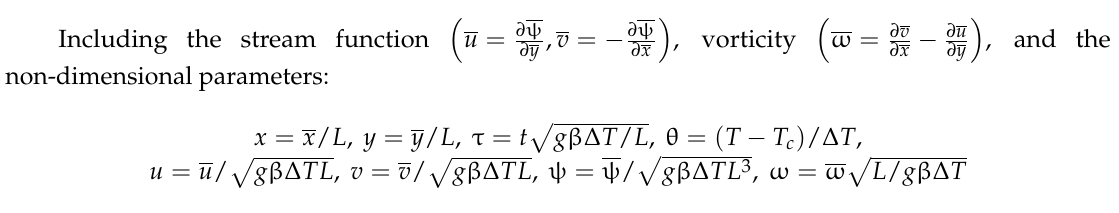
Figure 1. Analyzed region and reference frame.